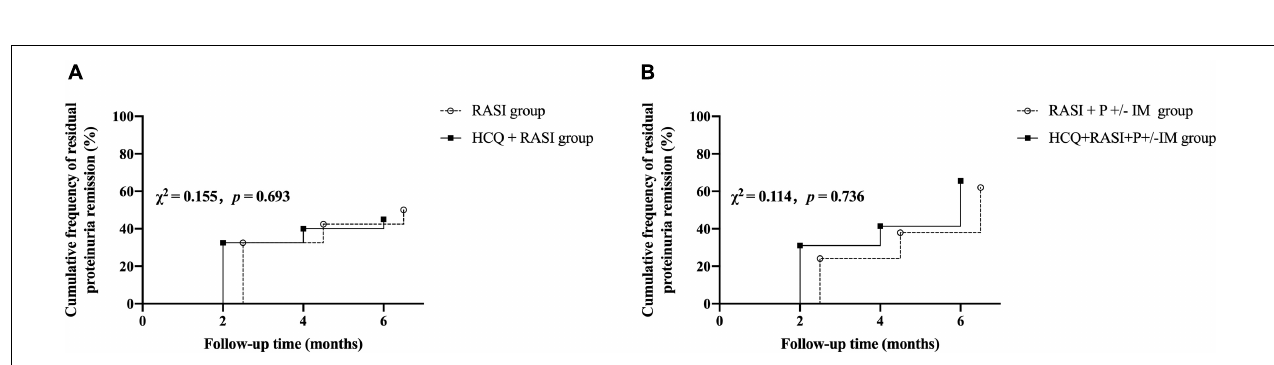
FIGURE 5 | The cumulative frequency of residual proteinuria remission during the follow-up period. (A) The RASI group vs. the HCQ + RASI group. (B) The RASI + P ± IM group vs. the HCQ + RASI + P ± IM